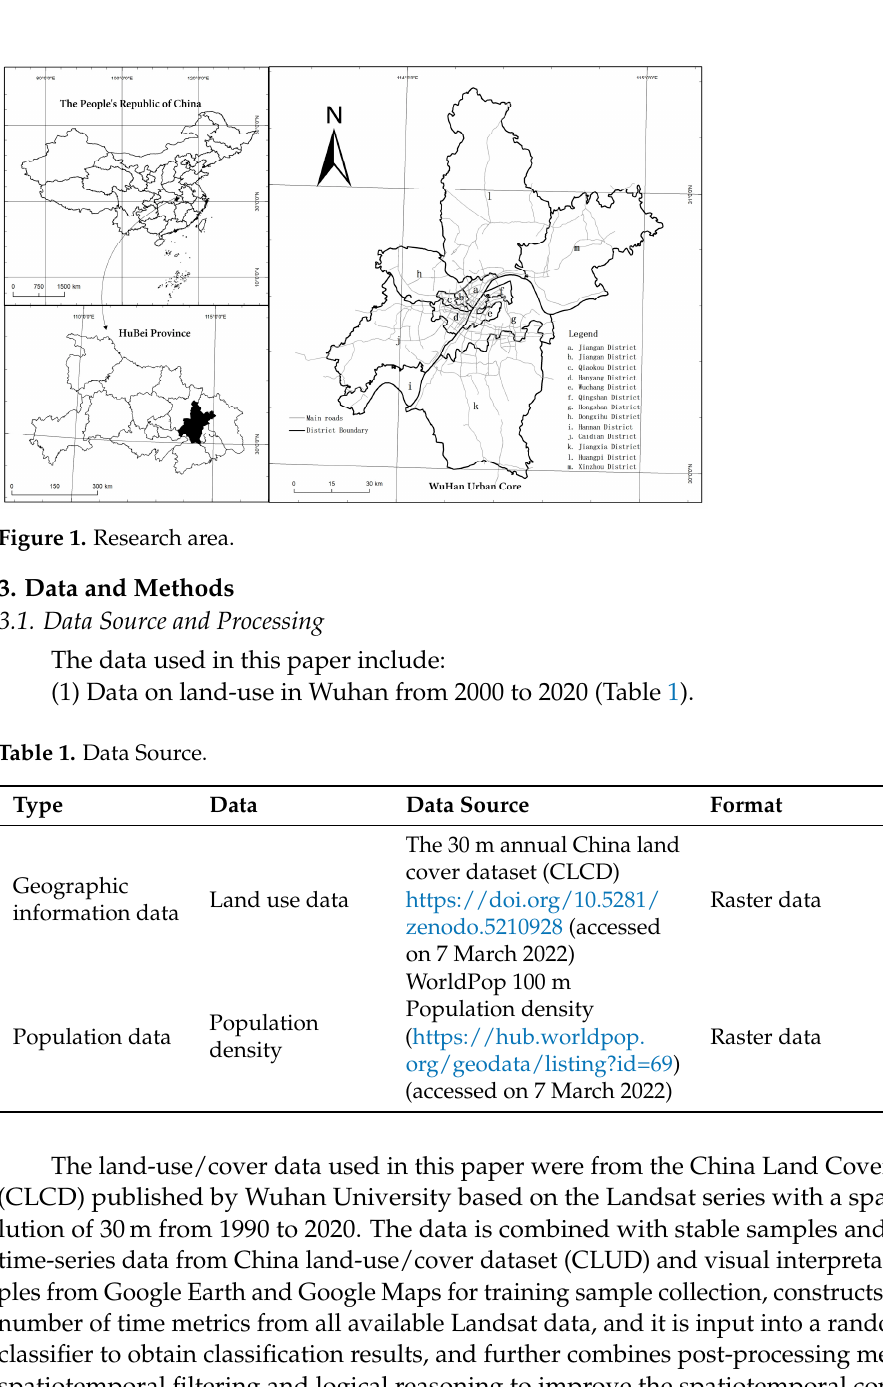
Table 1. Data Source.